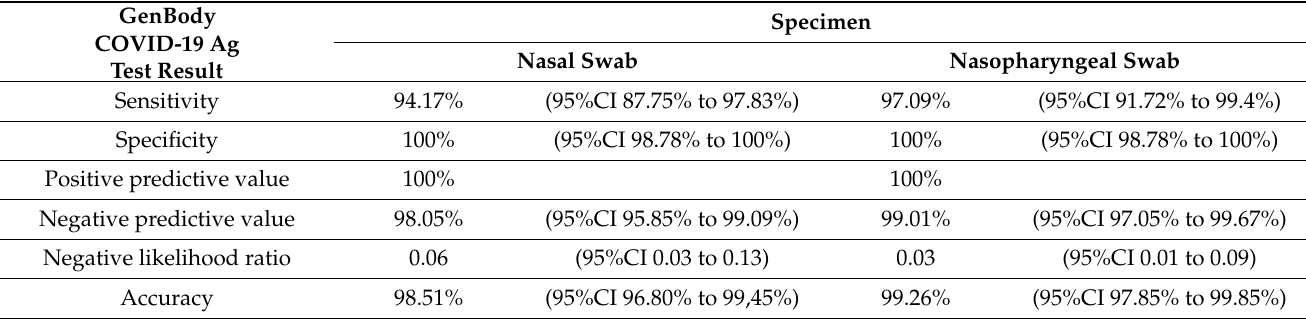
Table 4. Validation parameters for GenBody COVID-19 Ag